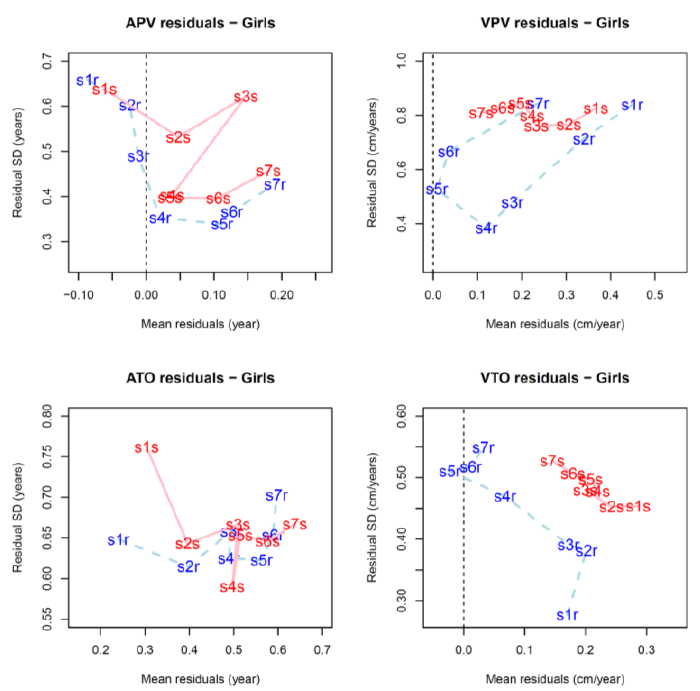
Figure 9. Residuals of the estimates of growth milestones between the FPCA (blue, dashed line) and SITAR (red, solid line) methods among girls; the standard deviations of residuals ( y -axis) are plotted relative to the mean residuals ( x -axis). Samples 1 to 7 are coded s1r to s7r (blue) for FPCA method and s1s to s7s (red) for SITAR method. Table 2. Descriptive statistics of the residuals (differences between estimates and reference values) of growth milestones (APV, VPV, ATO, VTO) for all testing samples (1 – 7), both sexes (girls, boys) and both tested methods (FPCA, SITAR); units of age estimates (APV, ATO) are years, units of velocity estimates are cm per year.